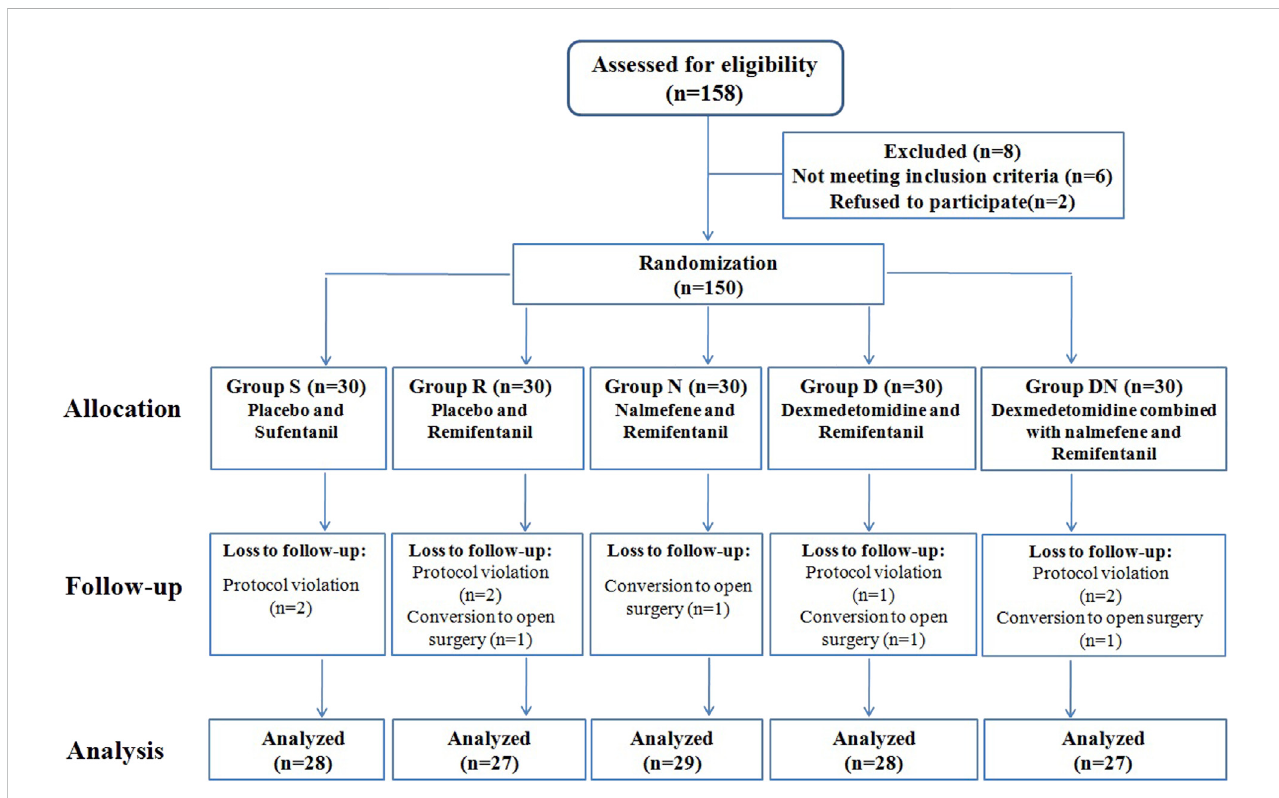
FIGURE 1 Consolidated Standards of Reporting Trials (CONSORT) fl ow